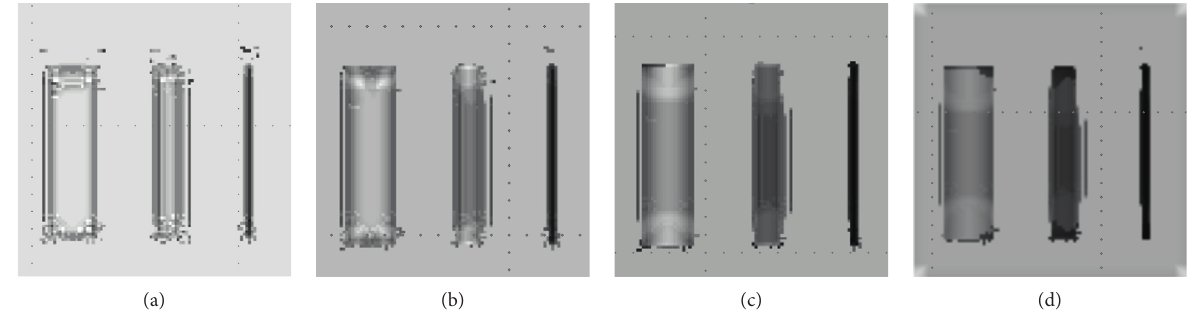
Figure 4: Percolation result of 100 resolution images using different window sizes: (a) 5 window size; (b) 10 window size; (c) 20 window size; (d) 30 window size.